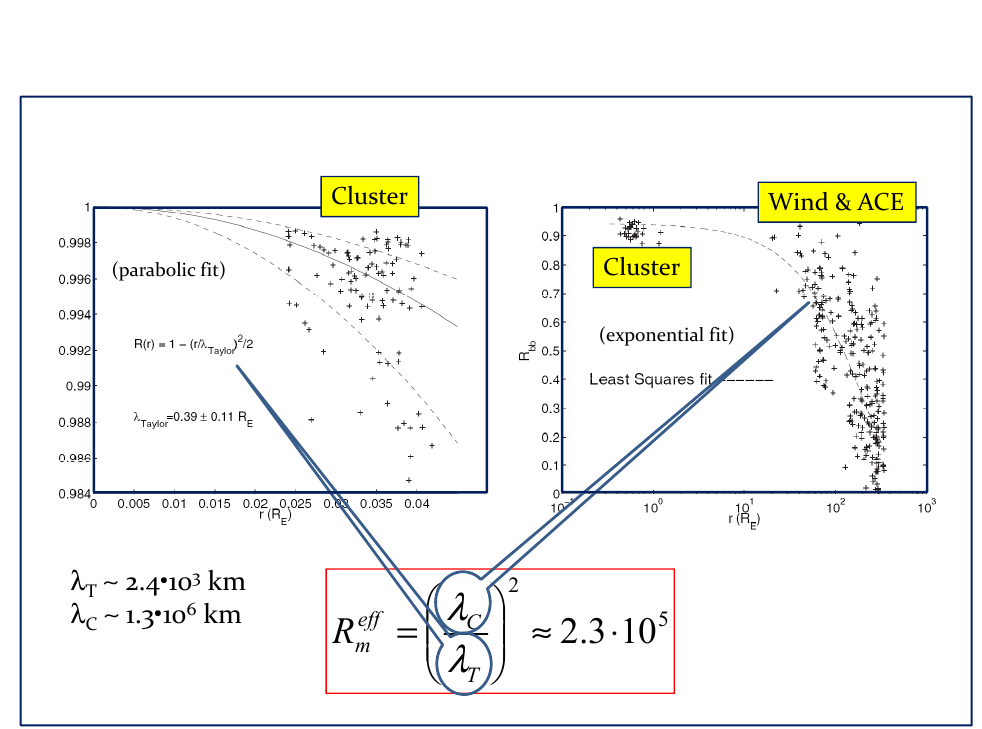
Figure 28: Left panel: parabolic fit at small scales in order to estimate 𝜆 𝑇 . Right panel: exponential fit at intermediate and large scales in order to estimate 𝜆 𝐶 . The square of the ratio of these two length scales gives an estimate of the effective magnetic Reynolds number. Image adapted from Matthaeus et al.